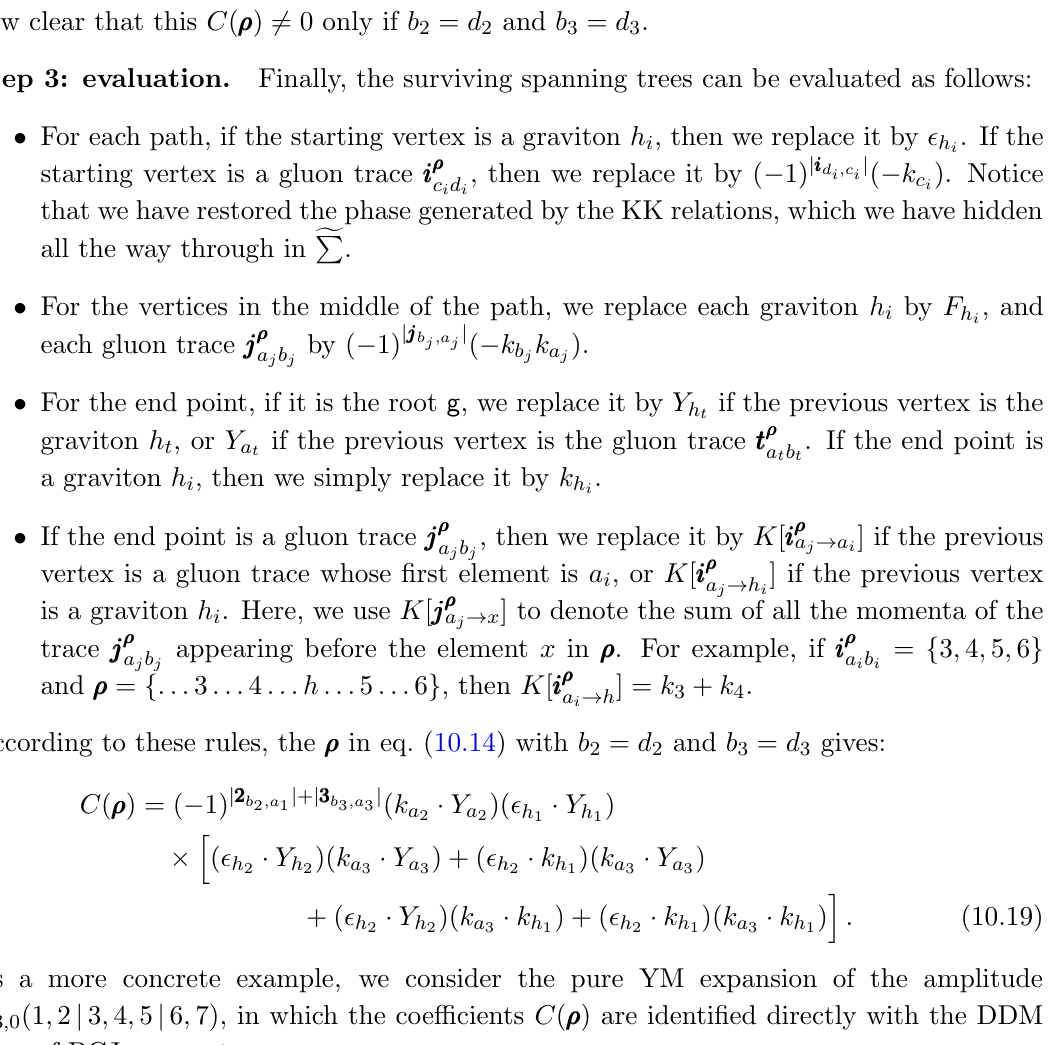
= d and b = d 2 2 3 3